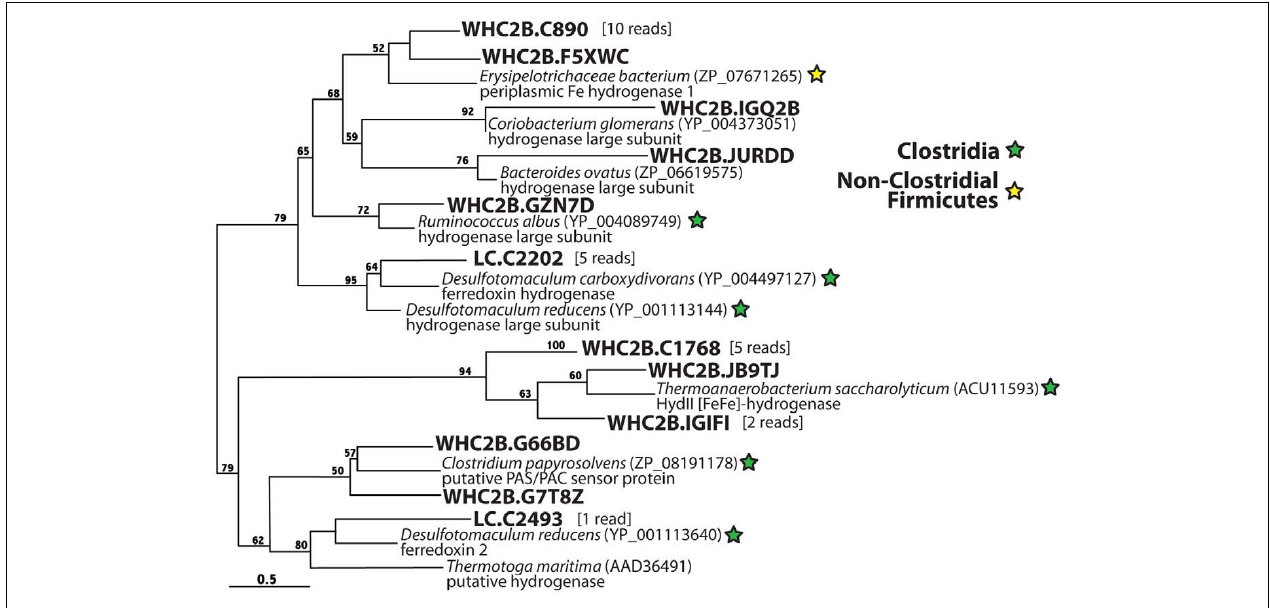
FIGURE 7 | Phylogenetic diversity of hypothetical [FeFe]-hydrogenases detected in metagenomes from a Lost City chimney andTablelands